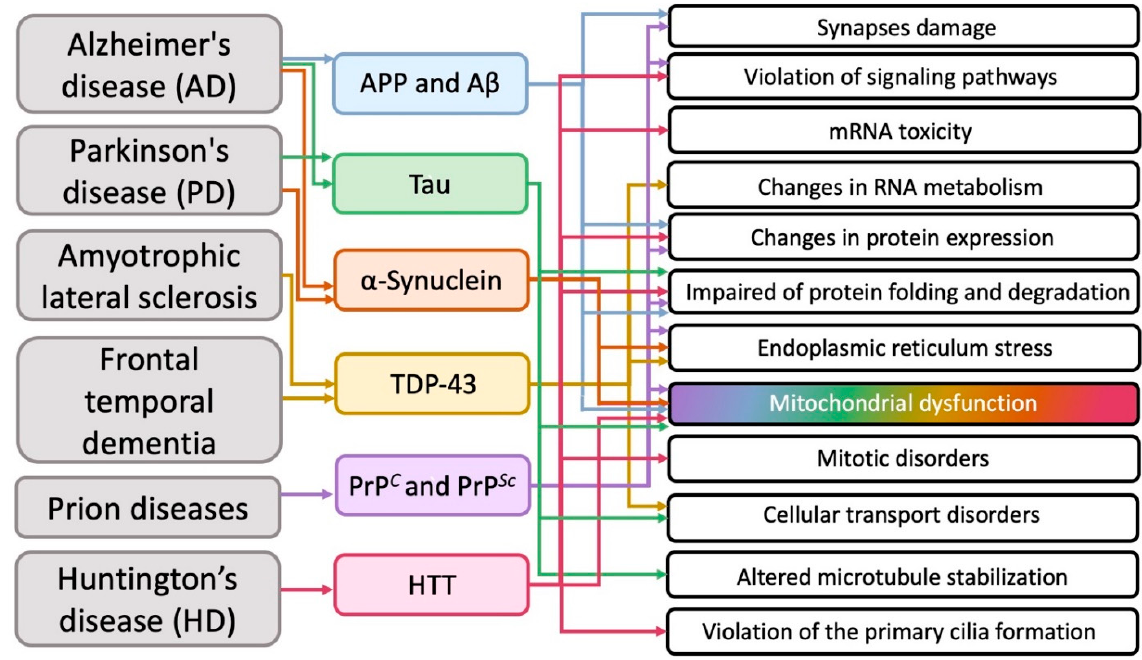
Figure 2. The main cellular pathologies developing during